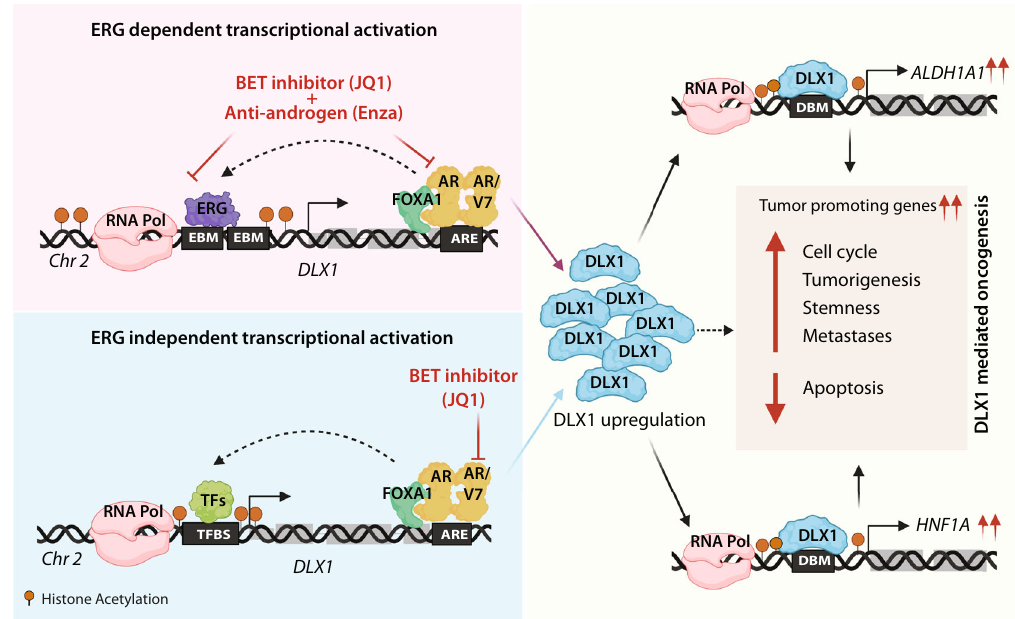
Fig. 9 Schematic showing transcriptional regulation of DLX1 and therapeutic utility of BET inhibitor and anti-androgen in suppressing DLX1-mediated oncogenic effects. Illustration depicting transcriptional regulation of DLX1 via ERG and AR-driven circuitry in ERG fusion-positive background, and through AR/FOXA1 in an ERG-independent context, thereby promoting cancer progression and metastases. In addition, DLX1 drives the expression of its target genes involved in stemness and oncogenesis, such as ALDH1A1 and HNF1A . Utility of BET inhibitor alone or in combination with anti-androgen drugs to target transcriptional regulators of DLX1 resulting in reduced expression of DLX1 and its downstream oncogenesis. Created with